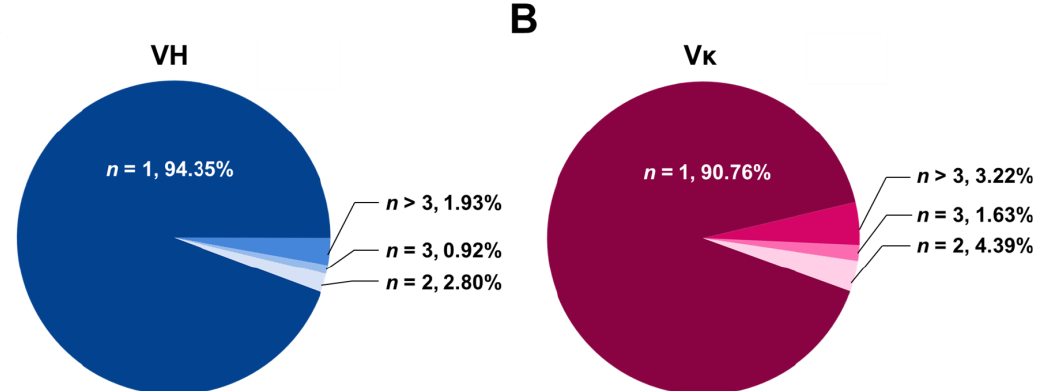
Figure 2. Redundancy of the variable domain sequences of the constructed library. The number of replicates ( n ) is expressed as a percentage of each heavy chain variable (VH) ( A ) and κ light chain variable (Vκ) ( B ) domain sequence out of the total analyzed sequences. Approximately 94% of VH and 91% of Vκ sequences were found to be unique sequences as shown here ( n = 1).